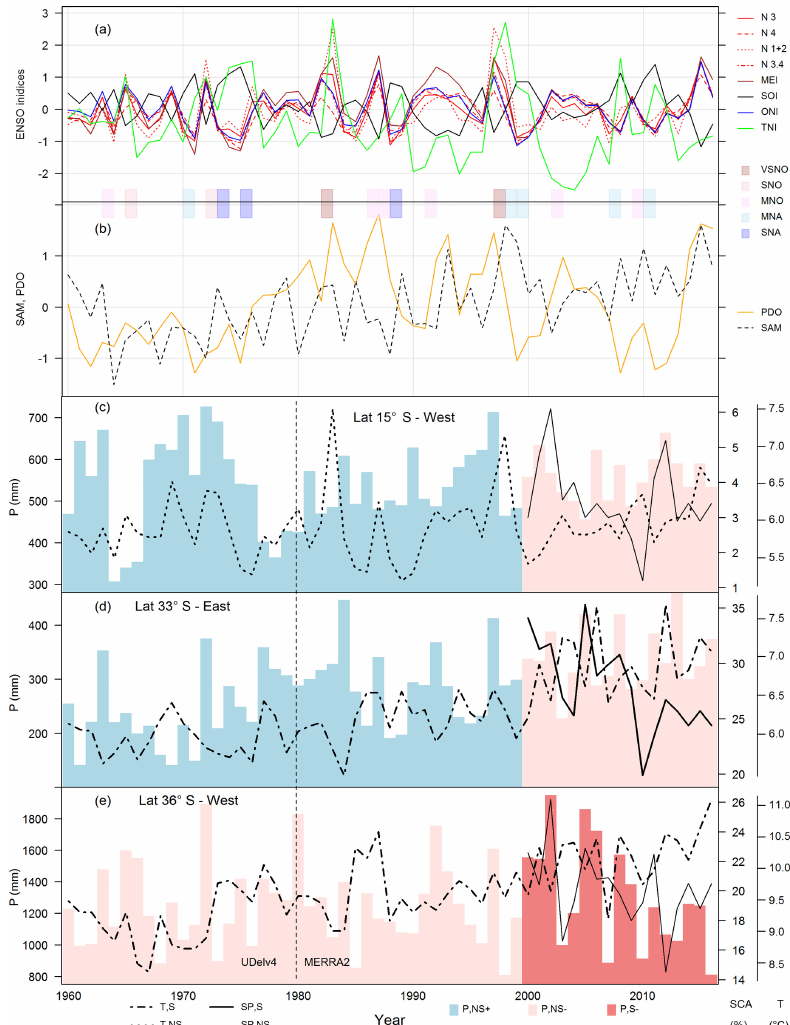
Figure 7. Comparison of the study time period (2000–2016) with the longer period of record since 1960. (a) Time series of ENSO indices of Niño events (Niño 3 (N 3), Niño 4 (N 4), Niño 1 + 2 (N 1 + 2), Niño 3.4 (N 3.4), Multivariate ENSO Index (MEI), Southern Oscillation Index (SOI), Oceanic Niño Index (ONI), and Trans-Niño Index (TNI)), (b) Pacific Decadal Oscillation (PDO), and Southern Annular Mode (SAM). Colored columns between panels (a) and (b) represent Niño events based on the ONI index, i.e., very strong Niño (VSNO), strong Niño (SNO), moderate Niño (MNO), moderate Niña (MNA), and strong Niña (SNA). Plots (c–e) show selected latitude bands (Fig. 6). Time series of temperature show a non-significant increase (dashed line; T , NS) and significant increase (point-lined line; T , S) from UDelv4 and MERRA2 datasets. Precipitation (solid column) has non-significant increase in light blue ( P , NS + ) (pink is P , NS − ) and significant trend in bold colors ( P , S − ) from UDelv4 and MERRA2 datasets. The annual average SCA from MODIS dataset as percentage of whole latitude band from 2000 to 2016 is represented, where a thick line (SP, S − ) indicates significance and a thin line is insignificance (SP, NS + ). The vertical dashed line in plots (c–e) shows the time change from UDelv4 to MERRA2